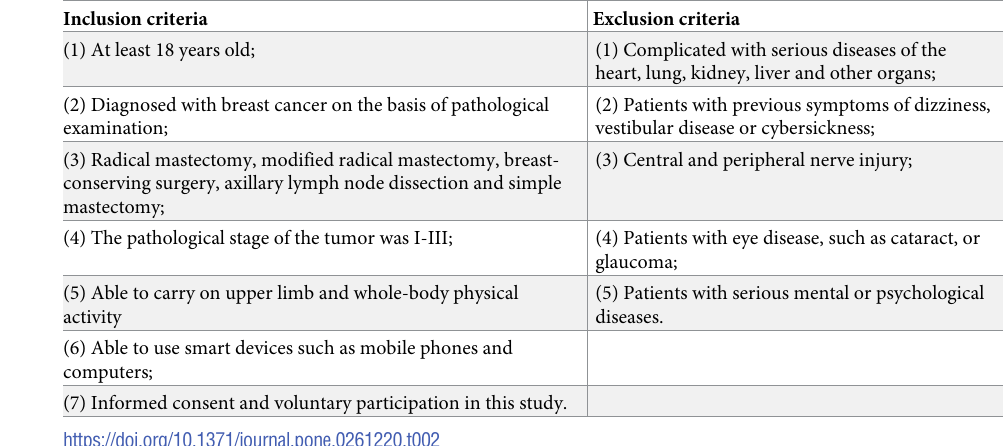
Table 2. Inclusion and exclusion